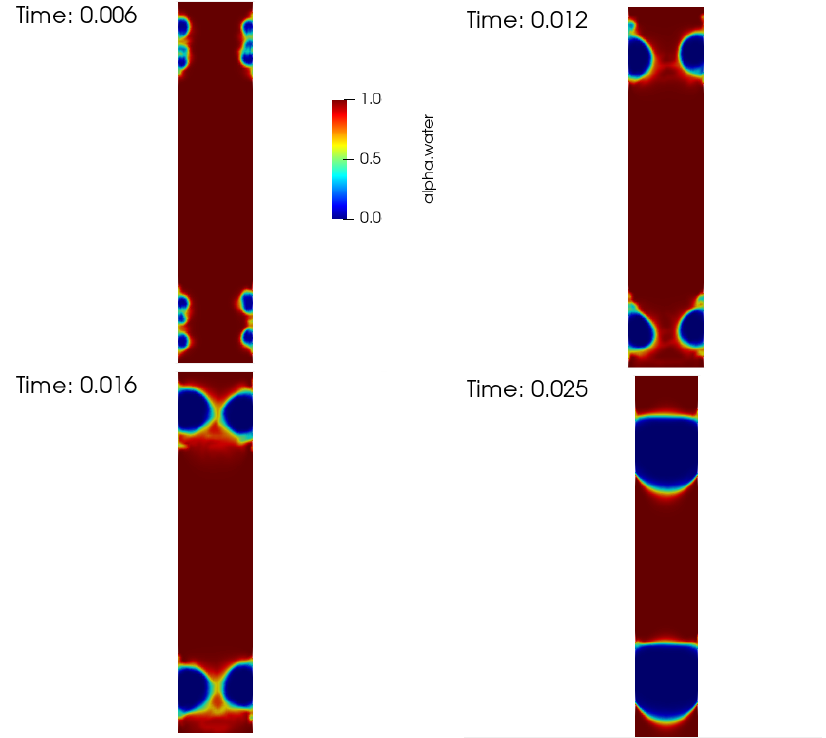
Figure 13. The distribution of ethanol volume fraction (alpha.water) in the evaporator area for the first milliseconds of simulation in the Kafeel and Turan [28] mass transport model for the case of 100 W input